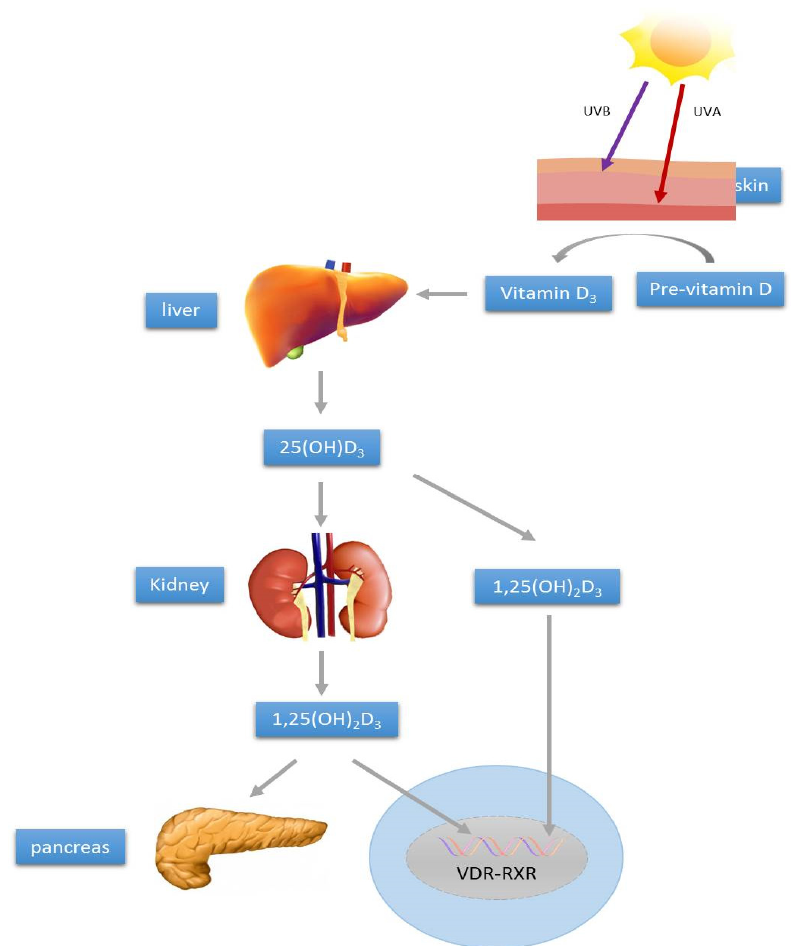
Figure 1. Schematic representation of vitamin D synthesis and metabolism in relation to regulation of pancreatic islet function and survival.